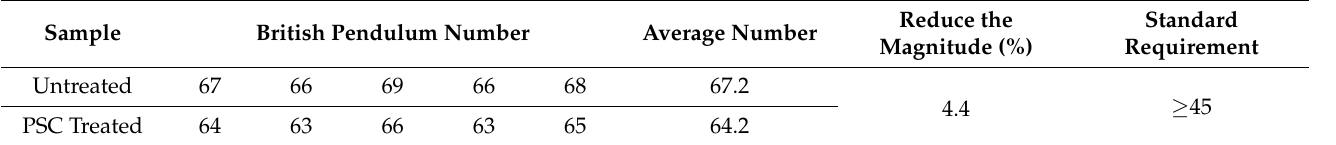
Table 6. Pendulum number test results. Figure 9. Point line graph of texture depth test results .